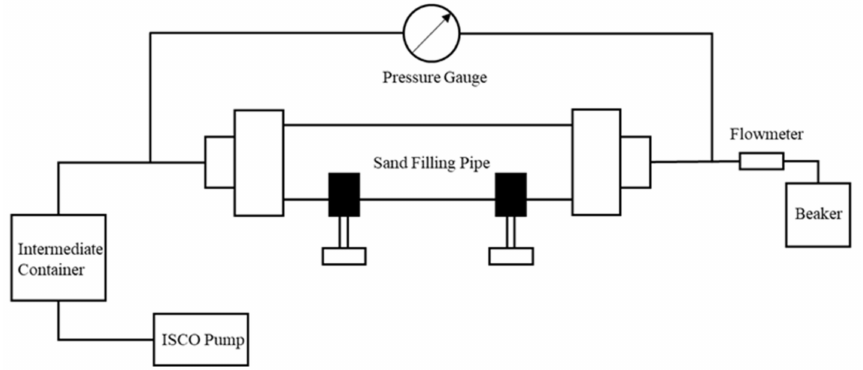
Figure 2. Sand-filled pipe displacement